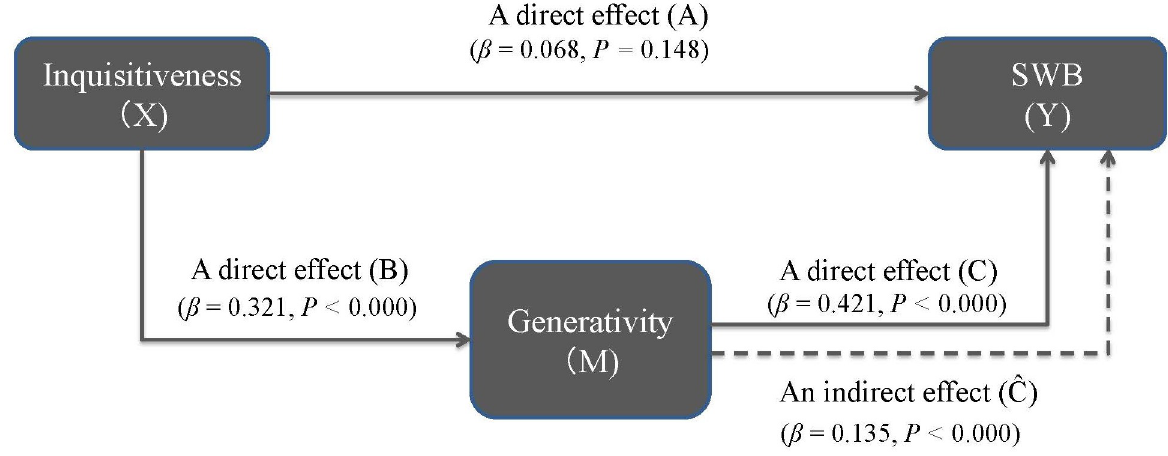
Fig 3. The mediating effects among inquisitiveness, generativity and